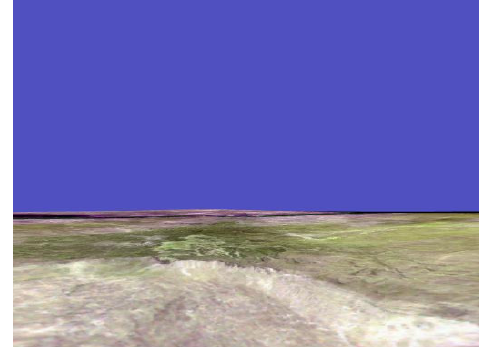
Figure 6. A computerized 3D landscape scene towards Tar al- Sbai from SW from the mosaic of Landsat-4 MSS images. Note the visibility to the Euphrates valley behind. Constructed by M. Törmä